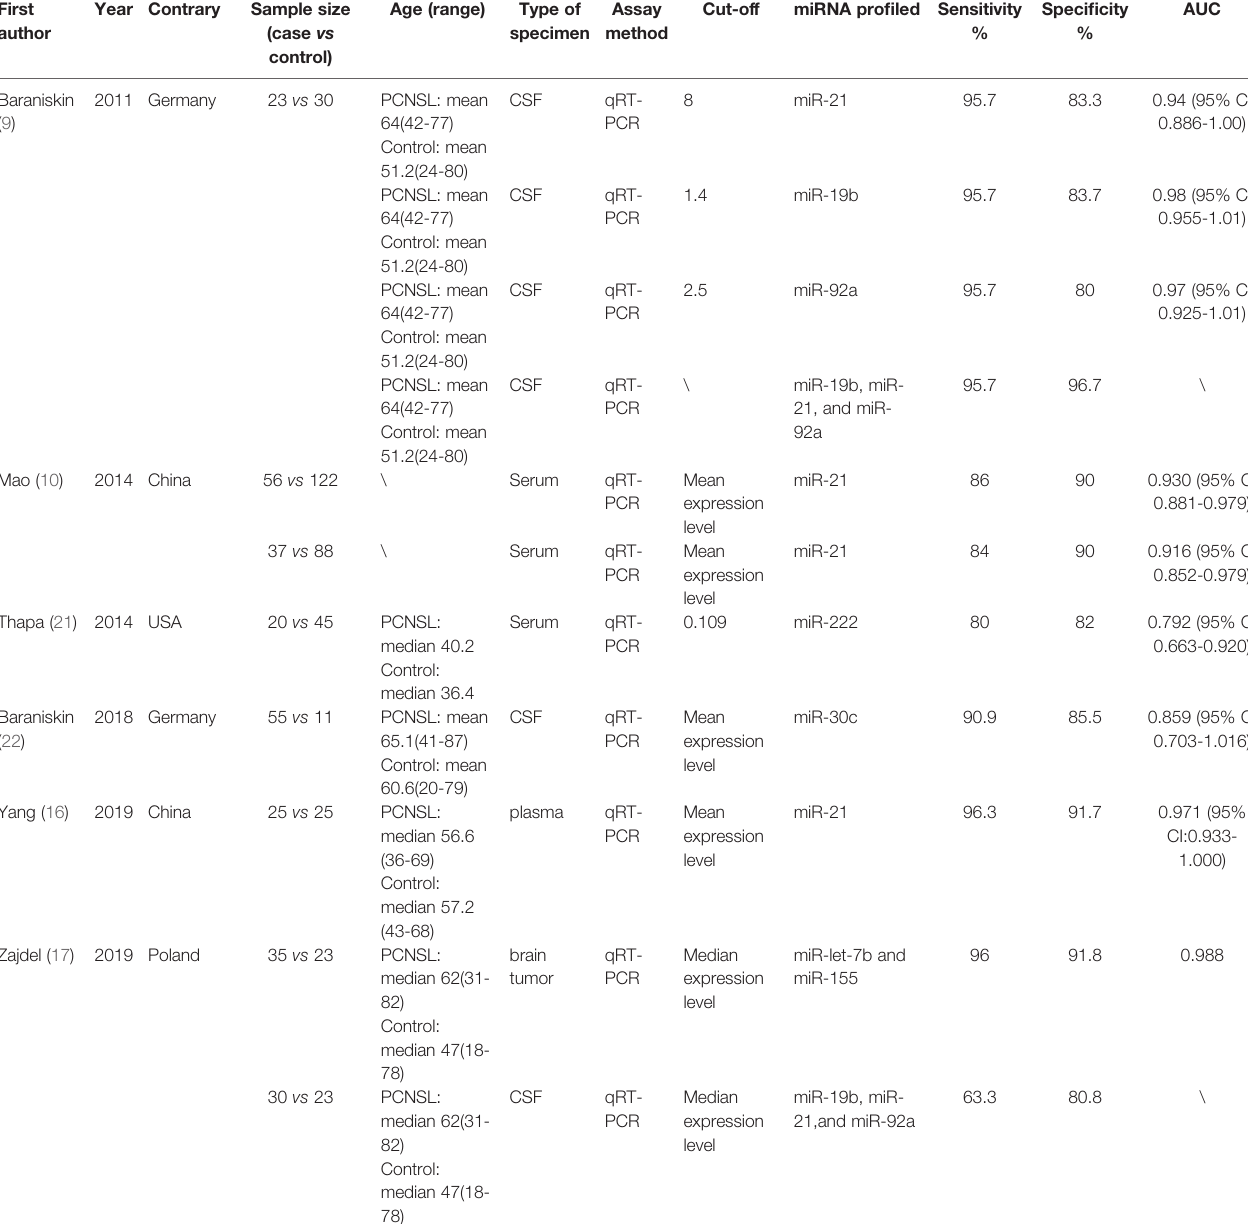
TABLE 1 | Characteristics of enrolled